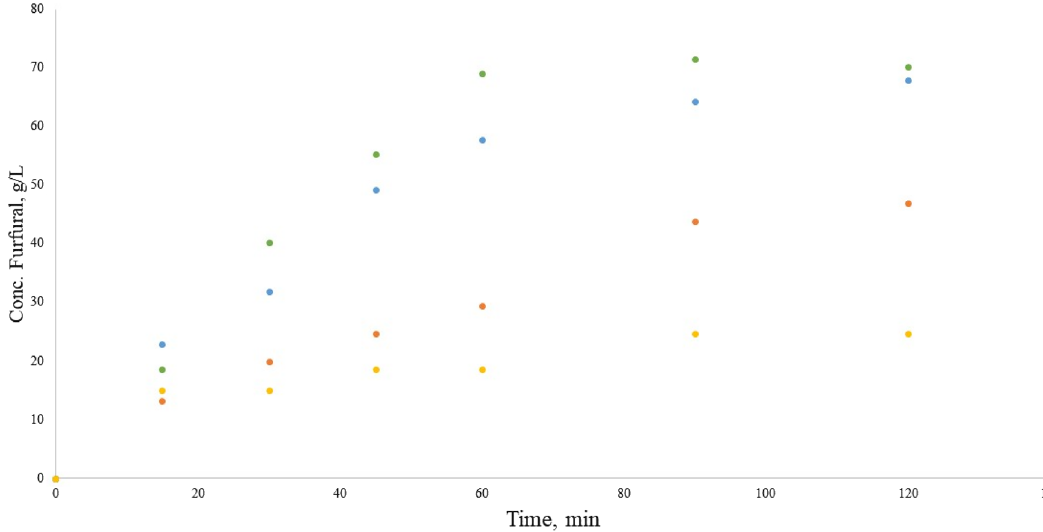
Figure 5. Furfural production in the Maillard reaction with Ca(OH) 2 , from orange pectin (blue circle), tangerine pectin (green circle), mango pectin (orange circle) and tamarind pectin (light orange